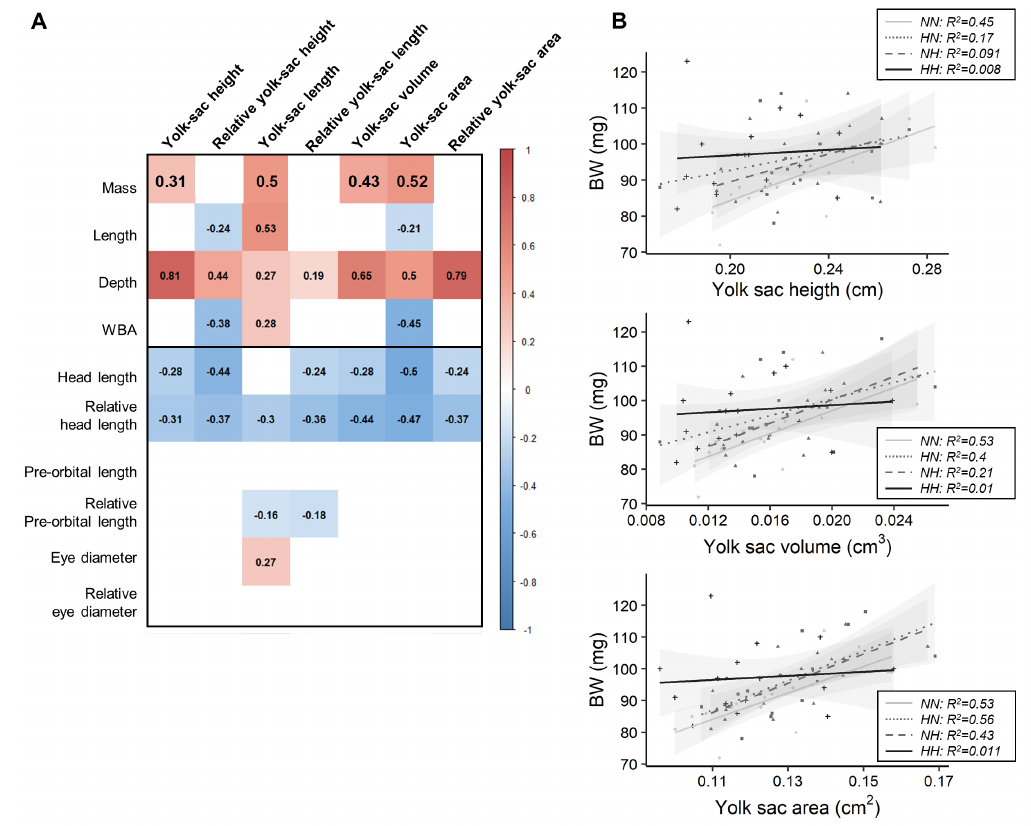
Figure 3. Relationships between growth and yolk-sac measurements. ( A ) Matrix of correlation between traits. Correlation were investigated using Pearson tests ( cut-off p = 0.01), and each value is indicated inside the matrix, while significant positive correlations are represented in red significant negative ones in blue. ( B ) Relationships between fry mass and yolk-sac height, volume, and area according to parental dietary